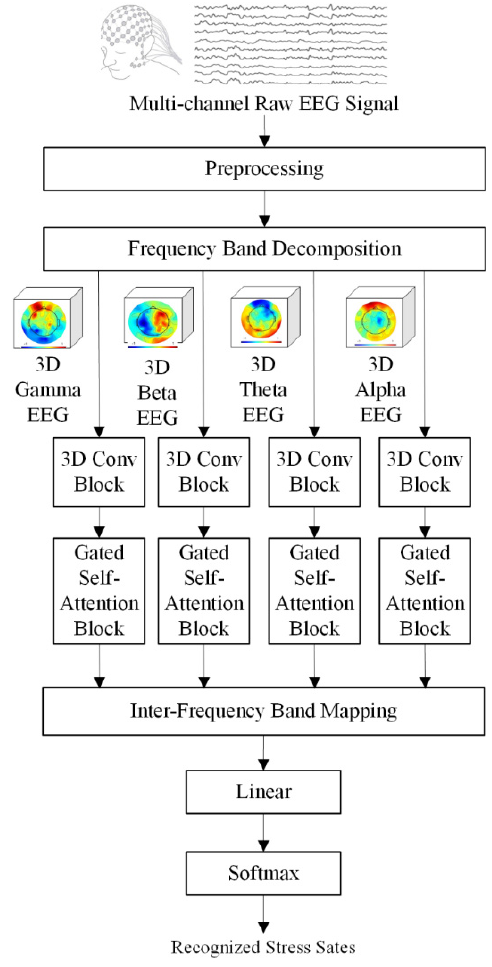
Figure 1. Structure and procedure of the proposed method.